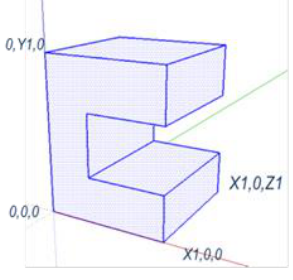
Figure 2. Parametric Shape Grammars.